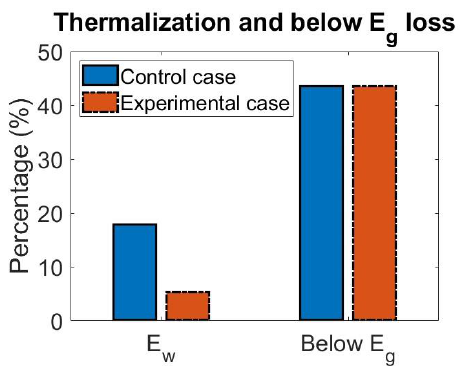
Figure 5. Amount of loss due to thermalization loss and loss due to below-bandgap photons in the perovskite layer between the control case and the experimental case. Table 3. Thermalization and below 𝐸 𝑔 loss between the control and experimental case. Thermalization Below 𝑬 𝒈